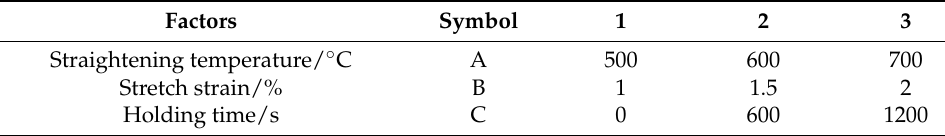
Table 3. Factors and levels of the orthogonal